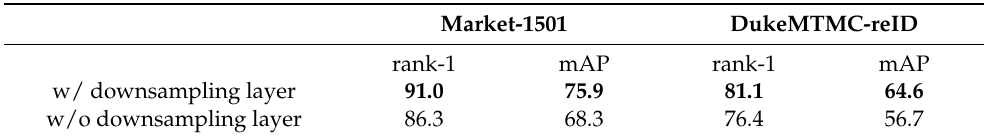
Table 2. Influences on rank-1 and mAP of the downsampling layer. w/and w/o denote that the downsampling layer is and is not removed, respectively. Bold fonts denote highest values.